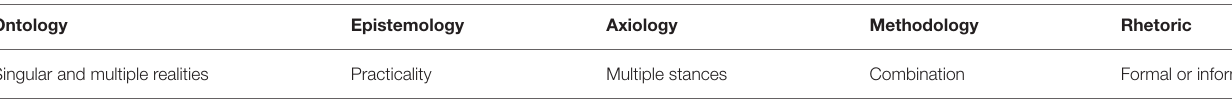
TABLE 1 | Philosophical assumptions of pragmatic worldview.